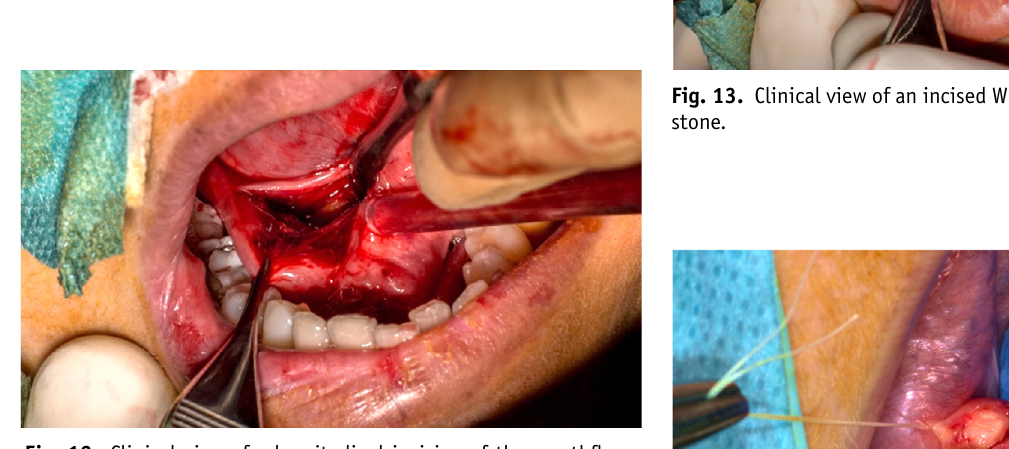
Fig. 12. Clinical view of a longitudinal incision of the mouth fl oor.